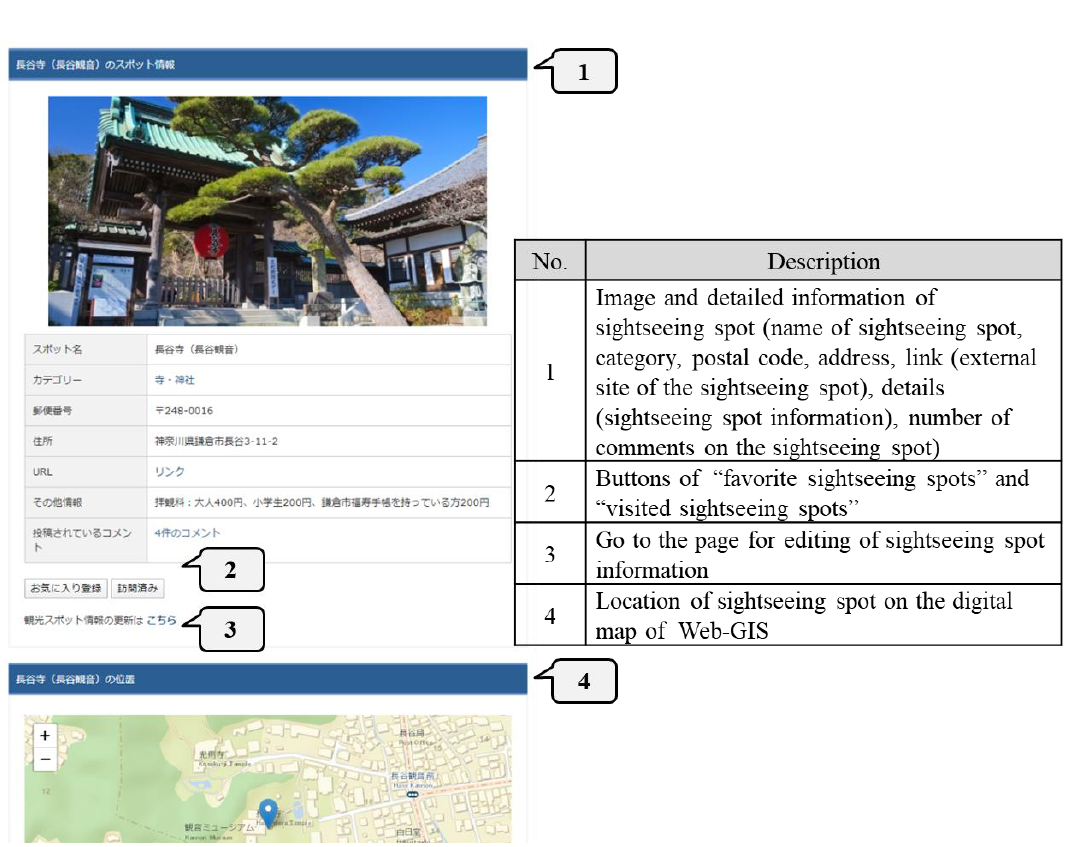
Figure 4. Page for detailed information of sightseeing spot.